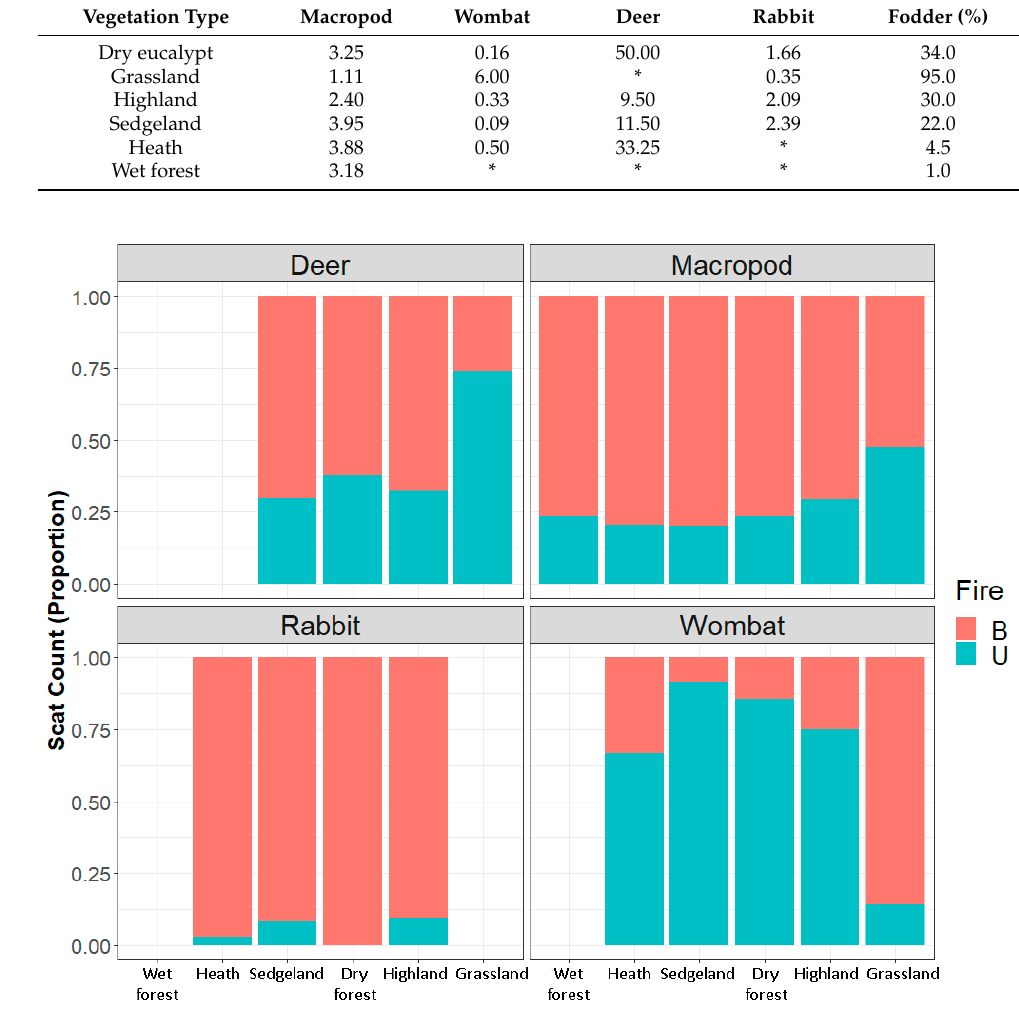
Table 4. Ratio of scats in burned quadrats to those in unburned quadrats by vegetation type and herbivore taxa. Fodder cover (%) by vegetation type is also shown. * = herbivore not present. Vegetation Type